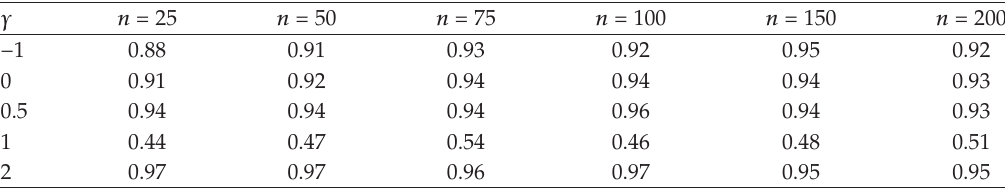
Table 5: Empirical coverage probabilities for the normal distribution , B (cid:6)